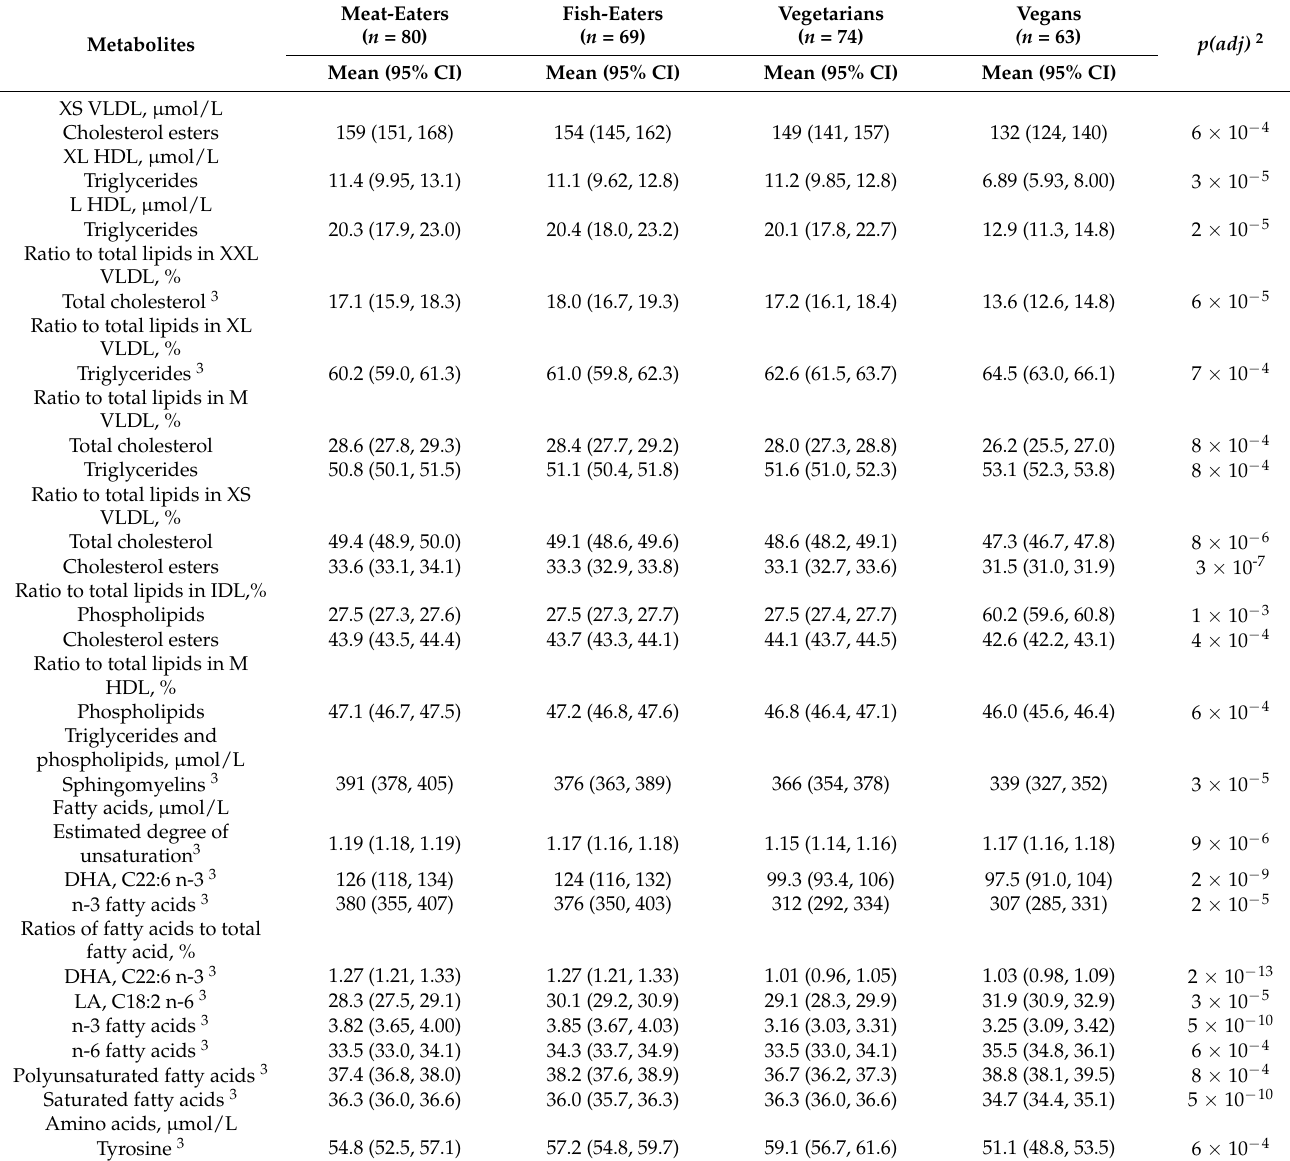
Table 2. Geometric mean of selected NMR metabolites by diet group on the original scale 1